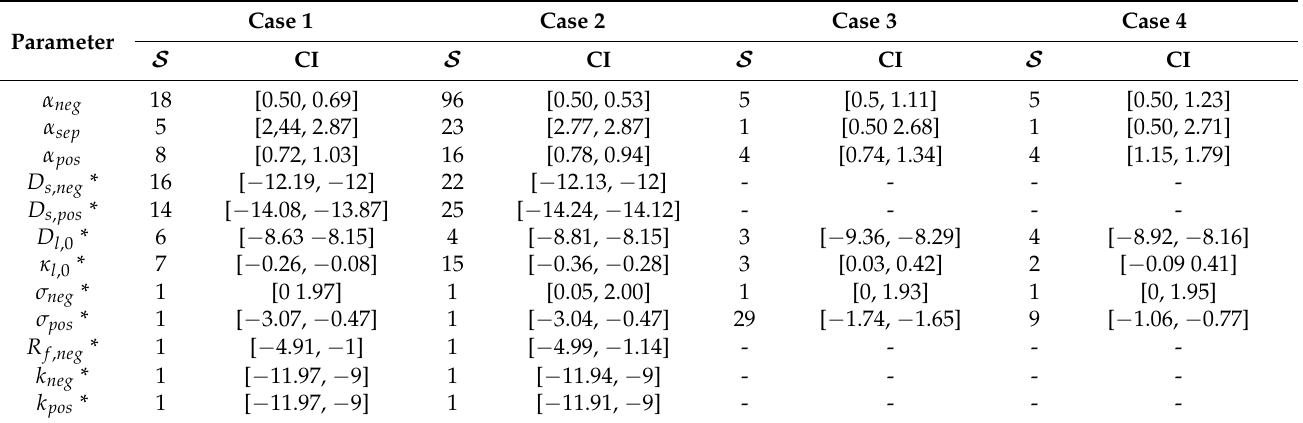
Table 5. Summary of the calculated SI and CI of the